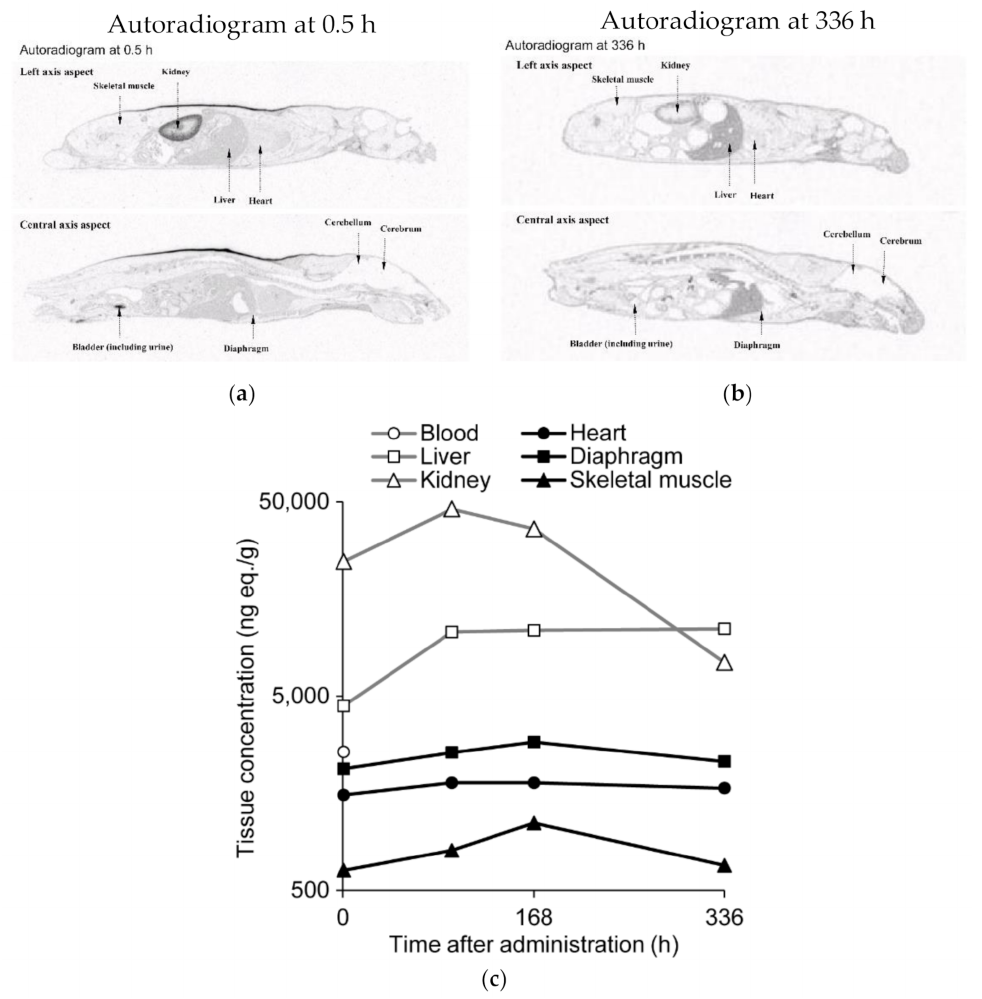
Figure 4. Concentrations of radioactivity in tissues after single subcutaneous administration of [ 14 C] renadirsen sodium at 10 mg/kg in C57BL/6 mice. ( a ) Autoradiograms at 0.5 h after administration. ( b ) Autoradiograms at 336 h after administration. ( c ) Concentrations of radioactivity in tissues were quantified by whole-body autoradiography (QWBA) at 0.5, 96, 168, and 336 h after administration. n = 1 per time point. Radioactivity in the blood (open circle) decreased below the limit of quantifica- tion at 96 h after administration. Open squares, open triangles, closed circles, closed squares, and closed triangles represent the liver, kidney, heart, diaphragm, and skeletal muscle,